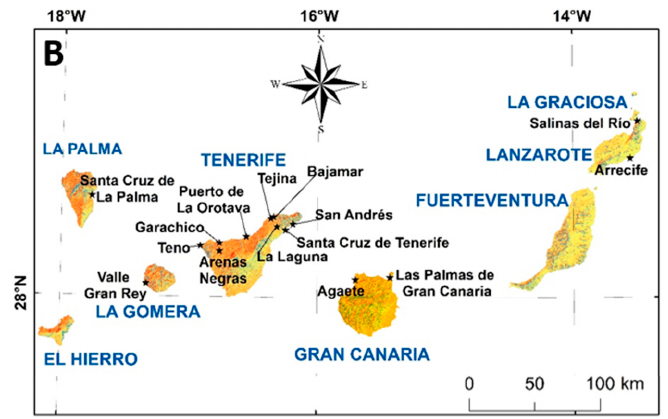
Figure 1. ( A ) Main tectonic and geodynamic features around the study area showing the Quaternary Faults from the Quaternary Faults Database of Iberia (QAFI) [32] and the tsunamis and earthquakes from the National Geophysical Data Center [33,34], as well as those studied in this work. Faults labelled as rift, step, tectonic contact and thrust-fault retrieved from Global Faults Layer form ArcAtlas (ESRI) [https://services.arcgis.com, (accessed on 8 March 2021)]. Background comes from OAG [https://ags.oag-fundacion.org/arcgis/services, (accessed on 8 March 2021)]. ( B ) Map of the Canary Islands showing the main localities mentioned in the text.